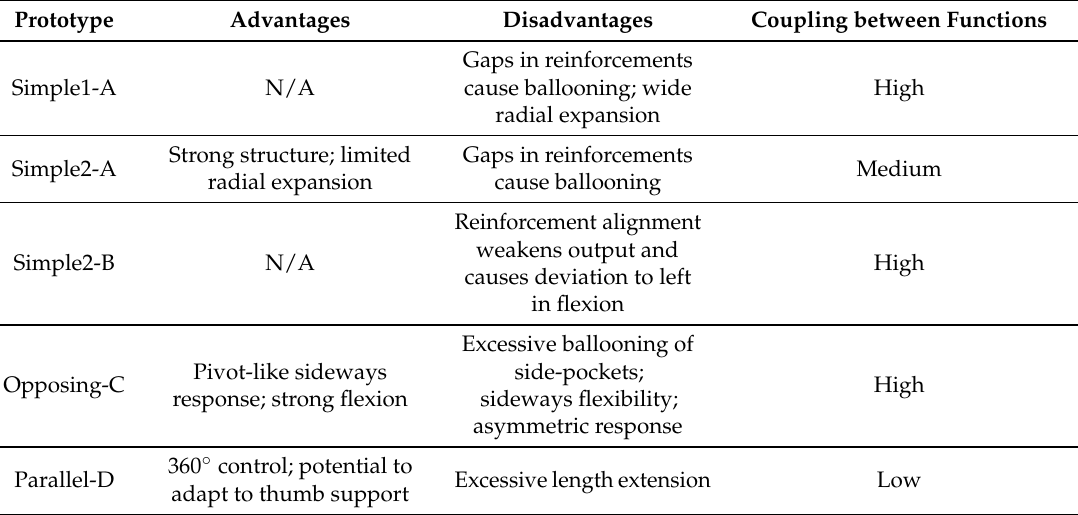
Table 5. Comparison of tested prototypes; advantages and disadvantages of each approach and relative level of coupling between the two